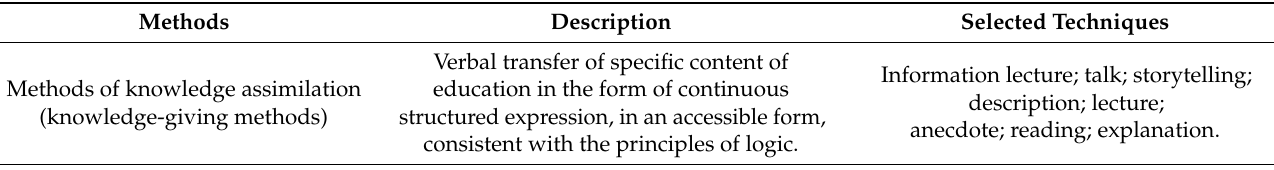
Table 1. Classification of teaching methods.